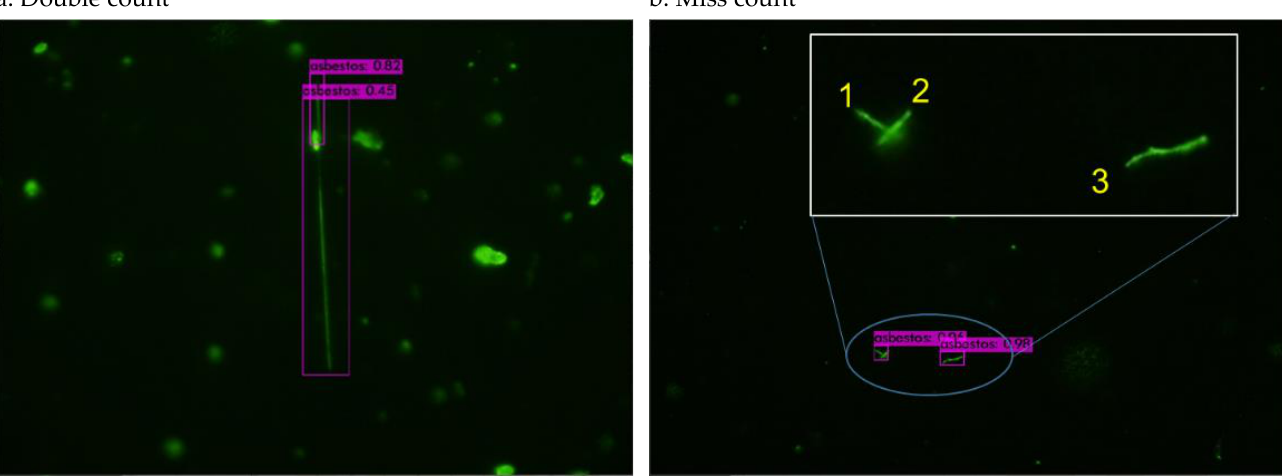
Figure 4. Double count ( a ) and miss count ( b ) examples.